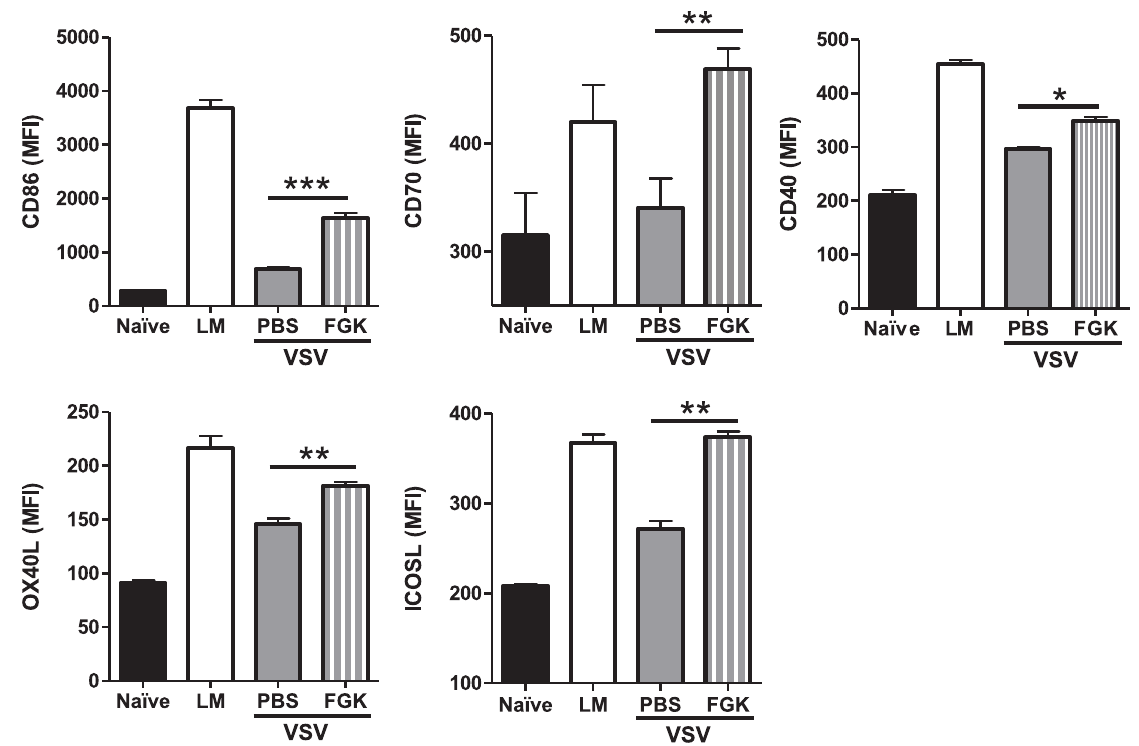
Figure 5. FGK4.5 treatment enhances dendritic cell maturation during VSV infection. C57BL/6 mice were either left uninfected or challenged with 2 6 10 3 cfu LM-ova, or 2 6 10 5 pfu VSV-ova with one group of VSV-ova infected mice treated i.p. with 100 m g FGK4.5 one day after infection. Three days after infection expression of the co-stimulatory molecules CD86, CD70, CD40, OX40L, and ICOSL on splenic dendritic cells (B220 neg CD3 neg NK1.1 neg F4/80 neg CD11c high I-A/I-E high ) was assessed. Data are representative of two independent experiments, with each experimental group containing 4–5 mice. Graphs represent the geometric mean fluorescent intensity (MFI) of each co-stimulatory marker 6 one standard error. Statistical significance was determined using an one-way ANOVA with a Bonferroni’s post-test (***p , 0.001; **p , 0.01).